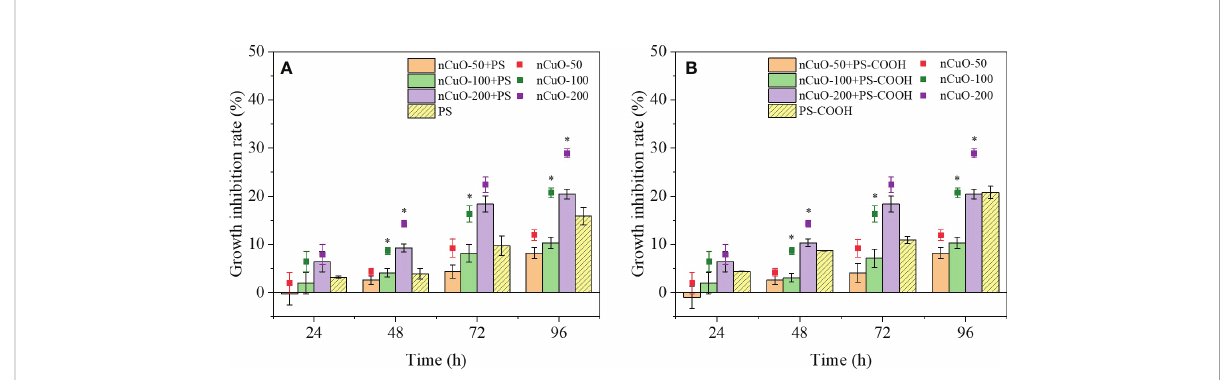
FIGURE 1 Combined effects of different concentrations of nCuO with 100mg/L PS (A) and PS-COOH (B) on the growth inhibition of P. helgolandica var. tsingtaoensis . Error bars represent standard deviations (n = 3). Asterisks indicate signi fi cant differences between single nCuO groups and the combined groups (P <